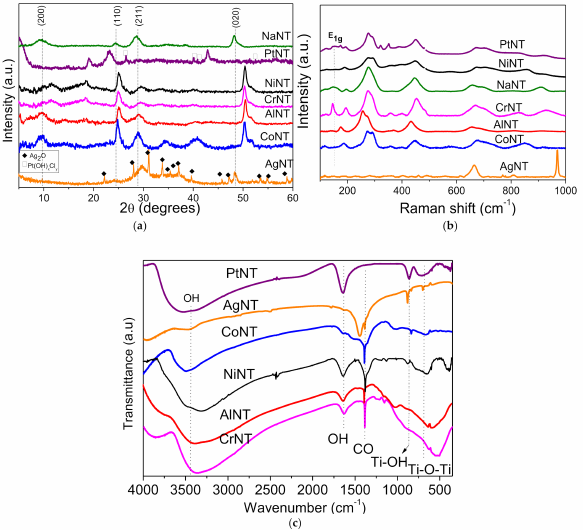
Figure 1. ( a ) XRD diffractograms, ( b ) Raman and ( c ) FTIR spectra of the catalysts studied. The main hkl reflections of Na 2 Ti 3 O 7 are shown in parenthesis above the diffraction